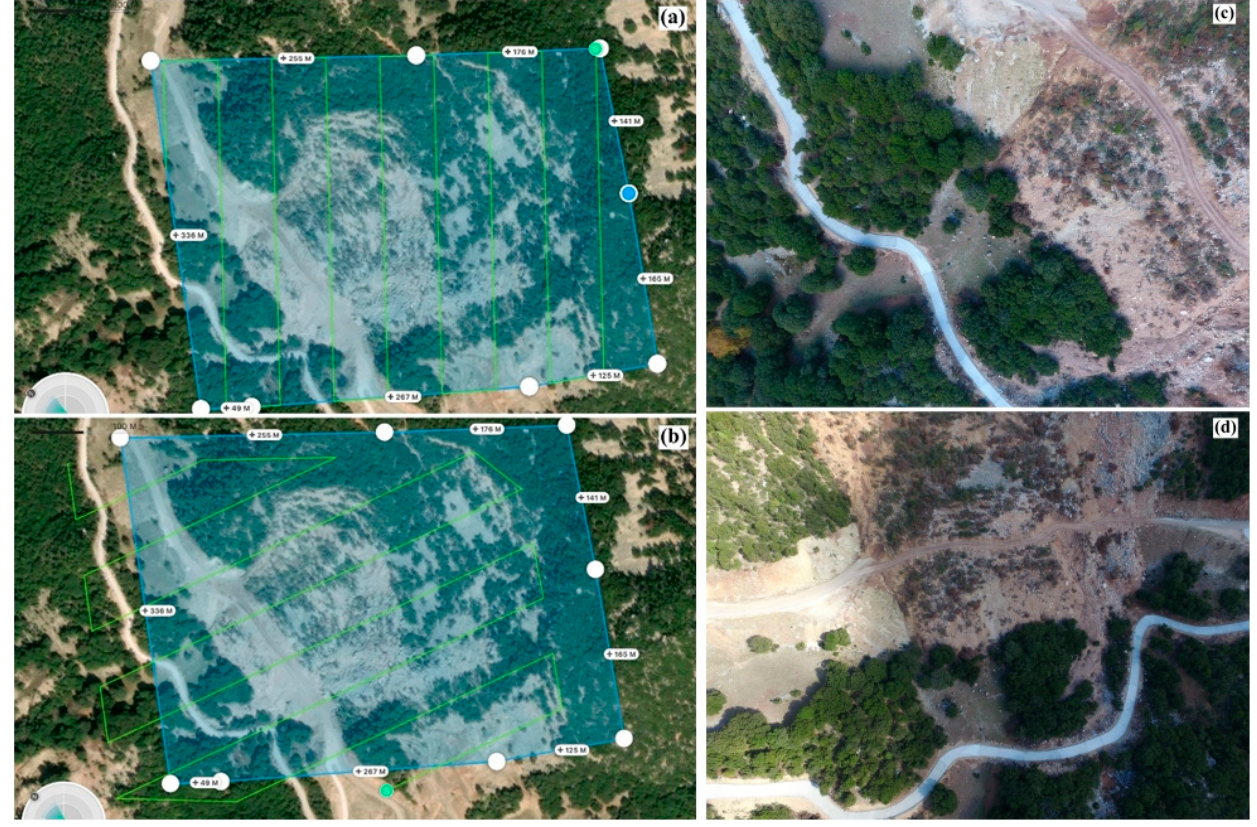
Figure 5. UAV acquisition trajectories. ( a ) Nadir-viewing grid trajectory. ( b ) Oblique-viewing grid trajectory. ( c ) Nadir- viewing image. ( d ) Oblique-viewing image.